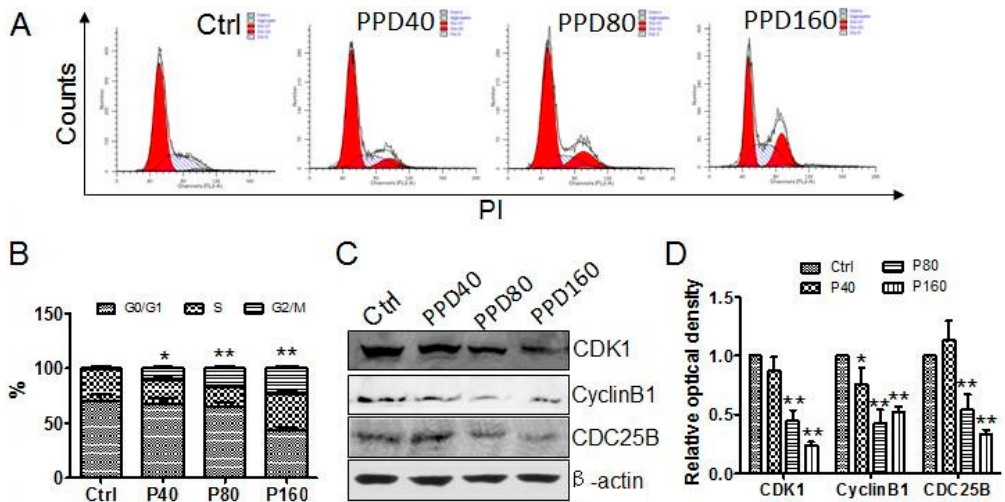
Figure 2. G2/M-phase arrest induced by PPD in Hep-2 cells. ( A ) FACS analysis of PPD inhibiting cell cycle in G2/M phase in Hep-2 cells. Cells were treated with 0, 40, 80 and 160 µ M PPD for 24 h, respectively, and then fixed, labeled with PI (Propidium Iodide), and subjected to flow cytometry; ( B ) The percentage of cells in different phase as shown in ( A ). Data are expressed as mean ± S.D., * p < 0.05, ** p < 0.01, compared to control, n = 3; ( C ) Western blot analyses of the expression of cell cycle related proteins in Hep-2 cells treated with different concentration of PPD; ( D ) The quantization of the Western blot data after correction for the β -actin loading control. Data are expressed as mean ± S.D., * p < 0.05, ** p < 0.01, compared to control, n =